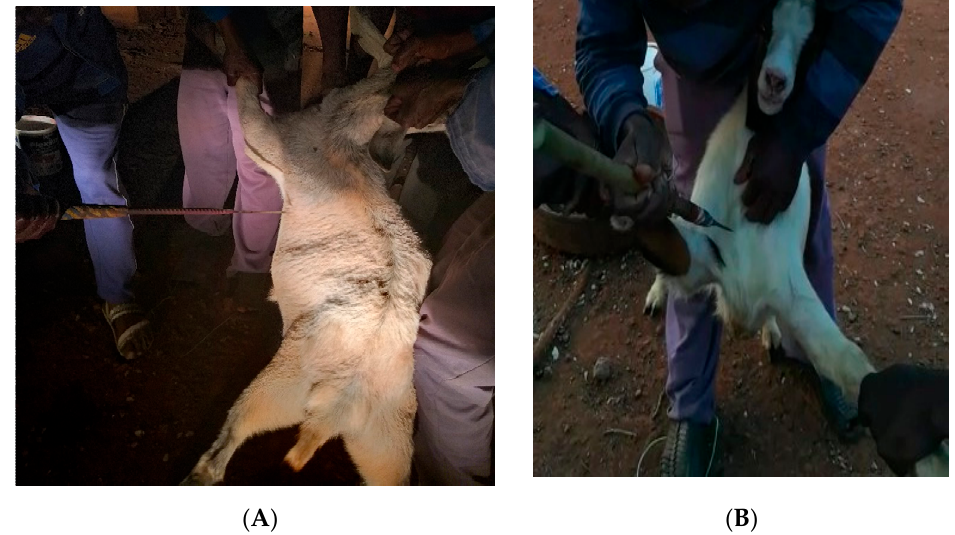
Figure 1. Visual pictures of the chest-floor point-of-elbow ( A ), and suprasternal notch piercing ( B ). Mdletshe et al. (2020), [12] with permission from MDPI.